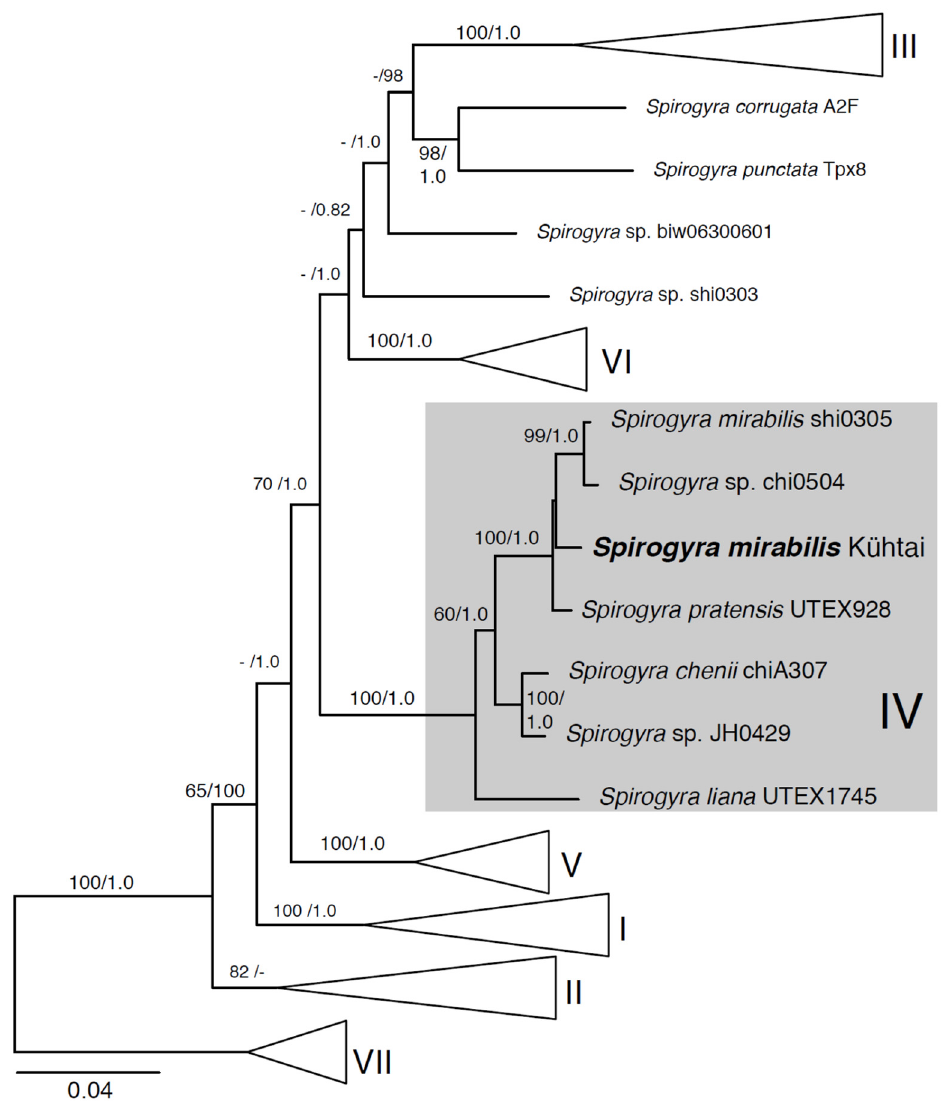
Figure 3. Summary of the maximum likelihood analysis of rbc L and atp B sequences from Spirogyra mirabilis (Kühtai) in the context of related and sequenced Spirogyra strains in clade IV, and for which the full tree is presented in Supplementary Figure S2. The tree is oriented, and the major clades are labeled, after Stancheva et al. [27] and Takano et al. [38]. Node support values correspond to ML bootstrap/BPP values. Scale bar indicates the expected number of substitutions/sites .